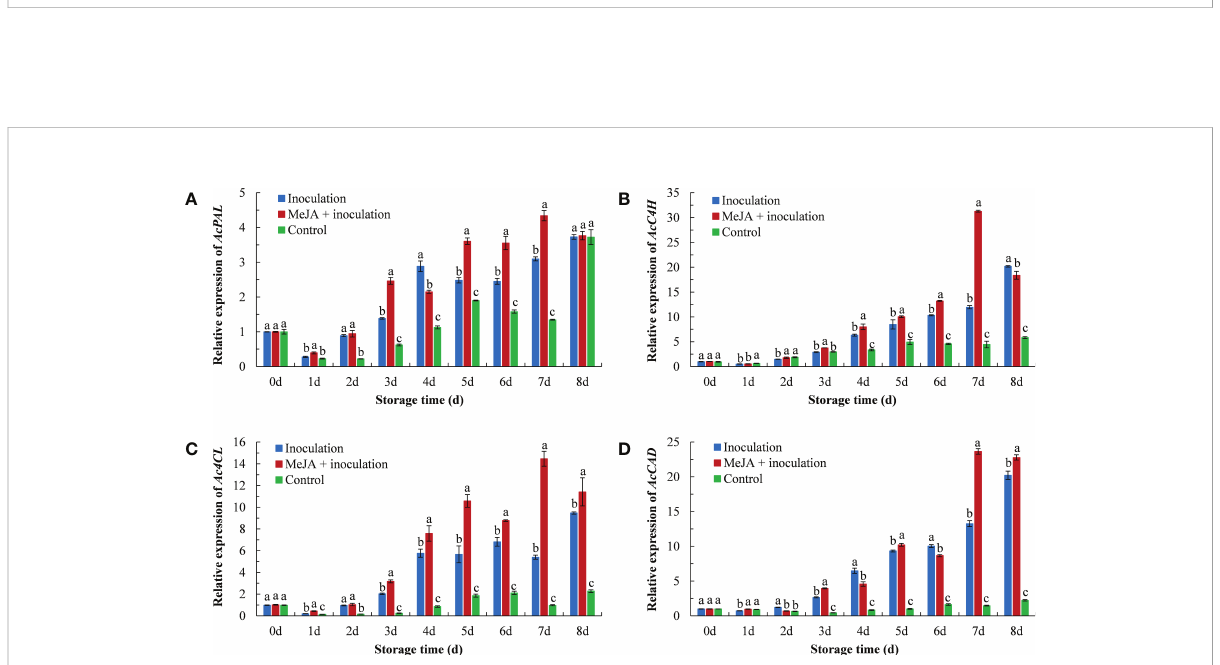
FIGURE 4 MeJA affected the gene expression of (A) AcPAL , (B) AcC4H , (C) Ac4CL , and (D) AcCAD in kiwifruit during storage time. Bars shows standard deviation (SD, n=3). Letters indicate signi fi cant differences at P < 0.05 level among the treatments.